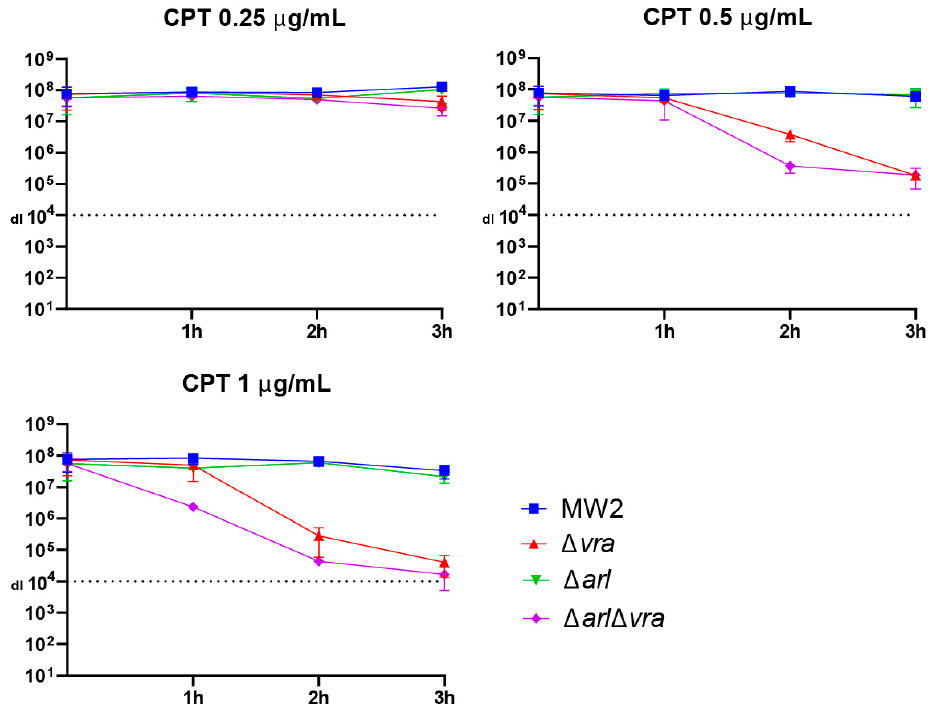
Figure 4. Early time-kill assay. The indicated four CA-MRSA MW2 strains and derivatives, all with equivalent MIC, were exposed to three concentrations (in µg/mL) of ceftaroline (CPT: 1/2 MIC, MIC, and 2 × MIC) in broth at 37 °C (Materials and Methods). Aliquots were removed every hour and viable cell titers were determined by serial dilution and plating on MHA plates without drug. The data represent the results of three biologically independent determinations and curves are plotted ± SD. Note that for CPT 0.5 and 1.0 conditions, the double arlRS/vraSR mutant consistently reduces viable cell titer faster than the single vraSR mutant strain.